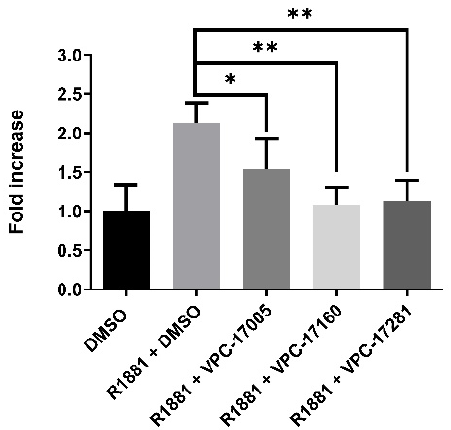
Figure 3. Anti-dimerization effects of VPC-17160 and VPC-17281 at 20 µ M concentraction. PC3